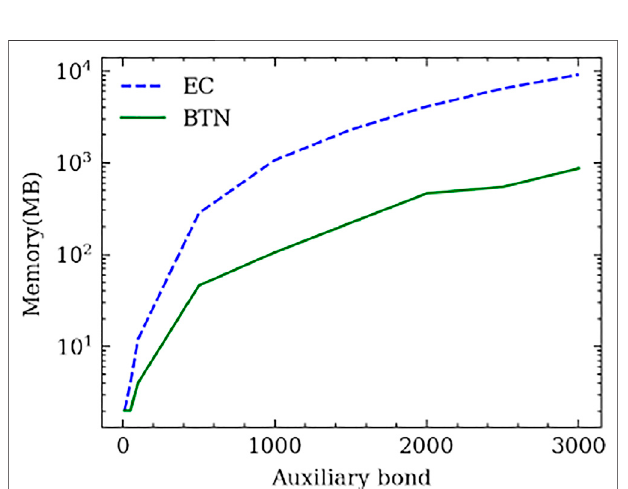
FIGURE 12 | Evaluation of the valid accuracy of MPS machine learning tasks on theMNIST dataset using three batch contraction methods:(red solid curve) the batch tensor network method (BTN); (green dashed curve) the ef fi cient coding; and (blue dotted curve) the loop method